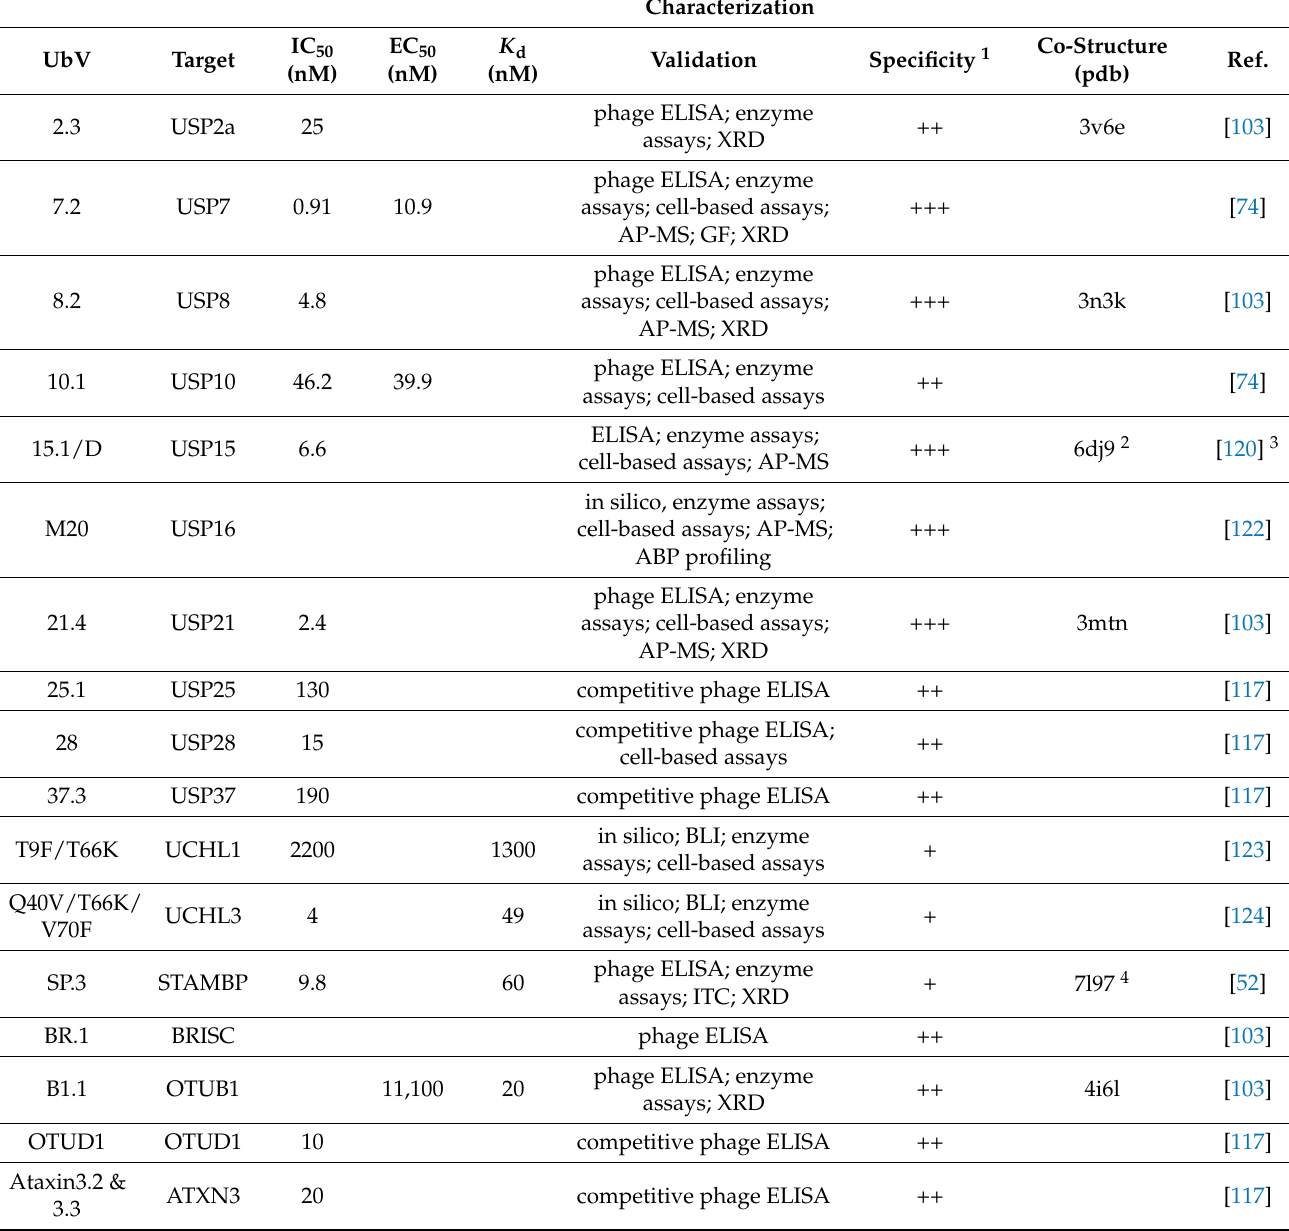
Table 2. UbVs and their cognate human DUB targets. Studies identify multiple UbVs during the initial screening and optimization. For simplicity, this table summarizes only a subset of the matured DUB